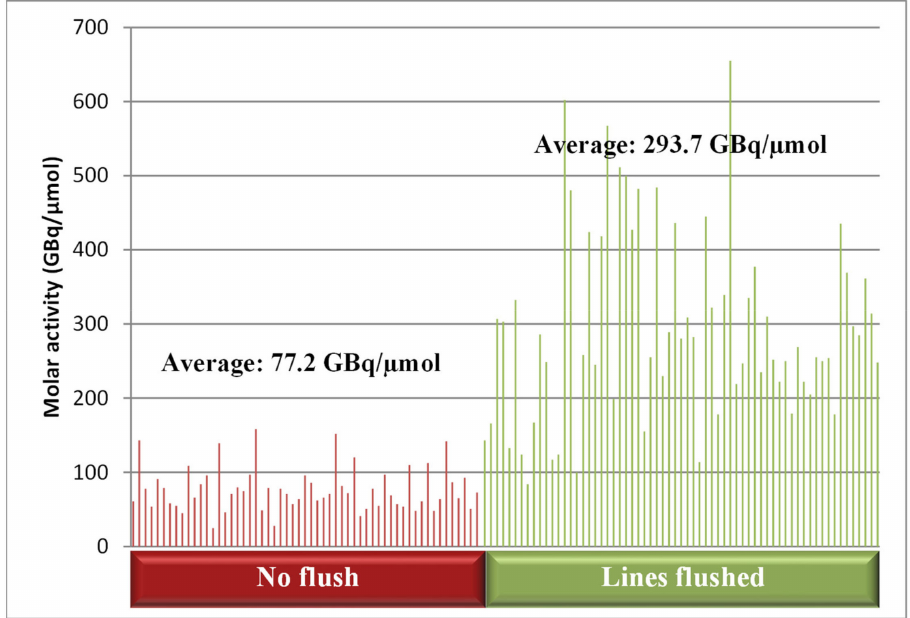
Figure 3. Comparison of the molar activity with and without flushing of the lines prior to